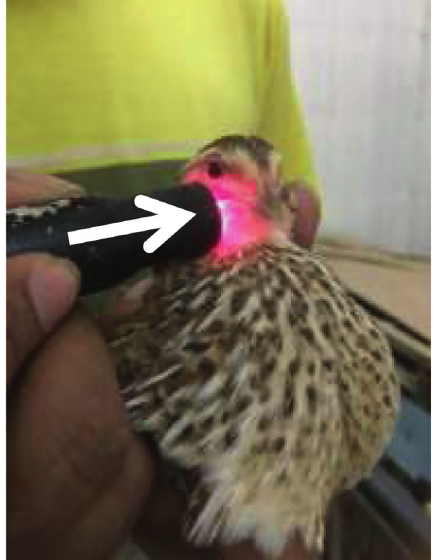
Figure 2: Laser puncture shooting at the Hu Men point.